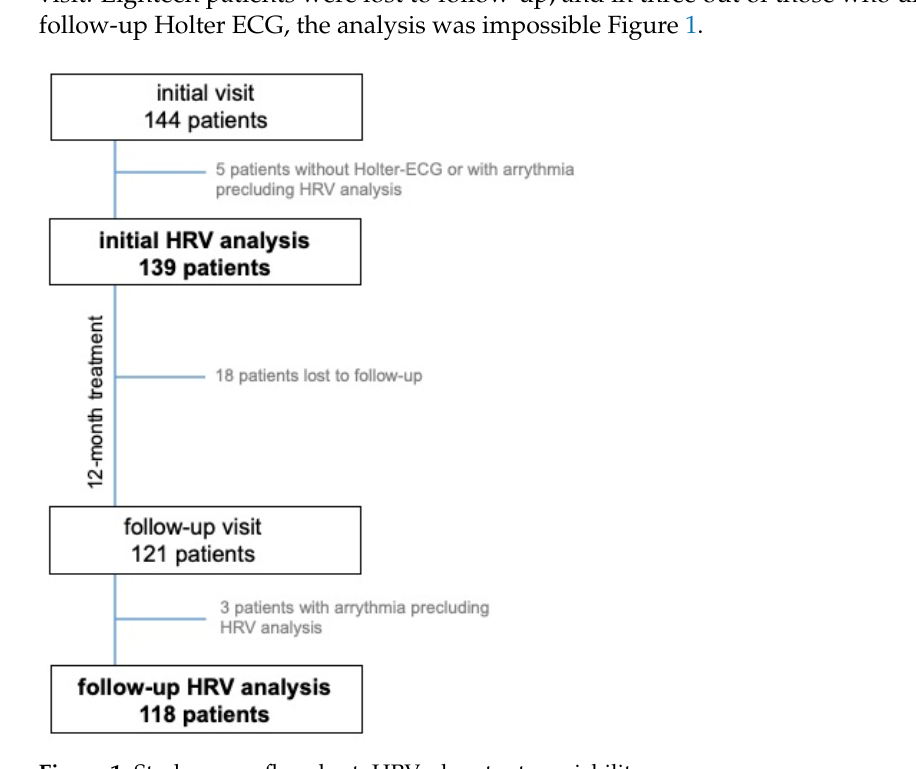
Figure 1. Study group flowchart. HRV—heart rate variability.